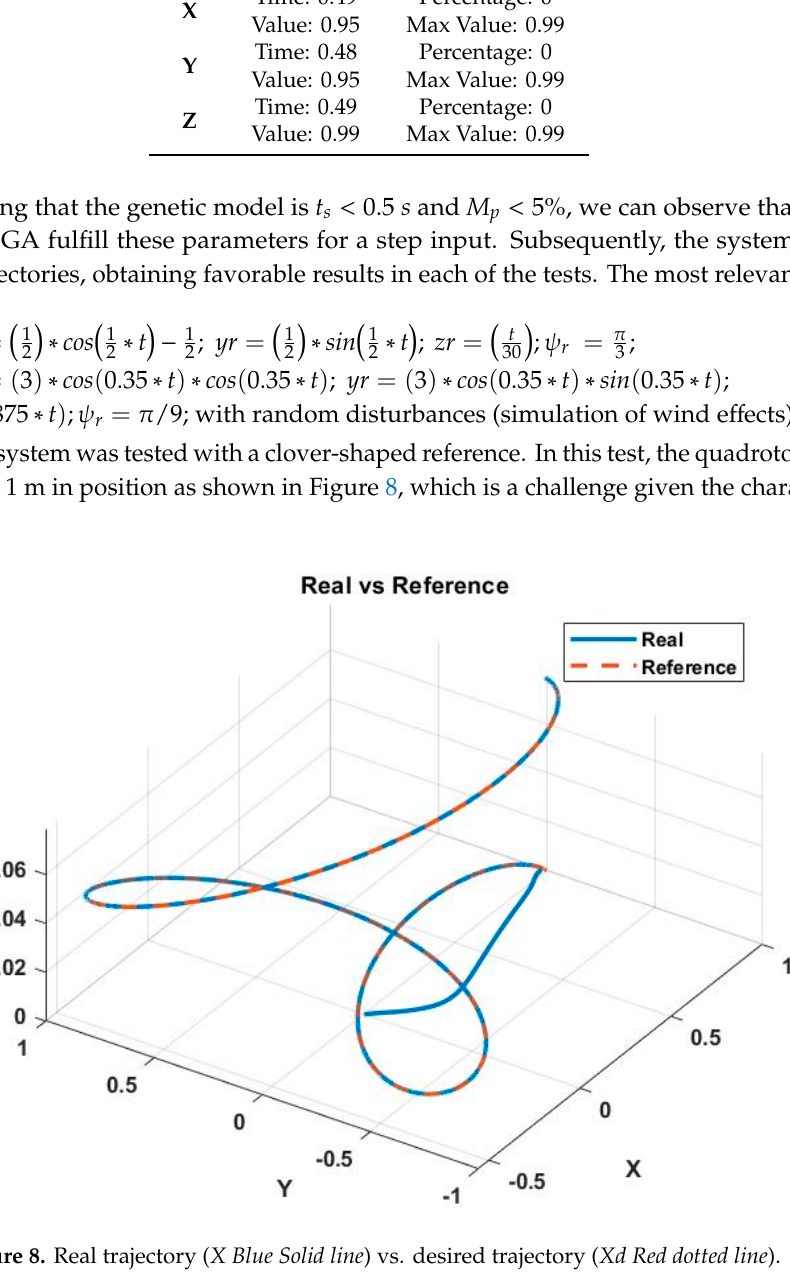
Table 3. Numeric results for step response.